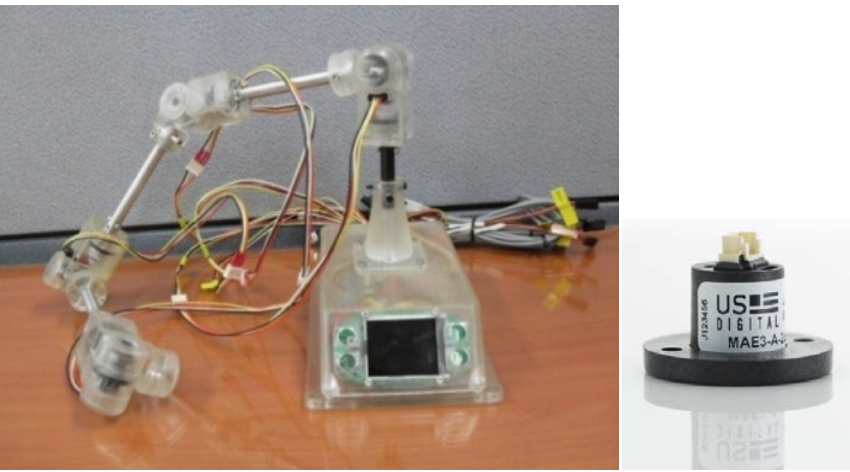
Figure 3. Fabricated serial linkage and absolute